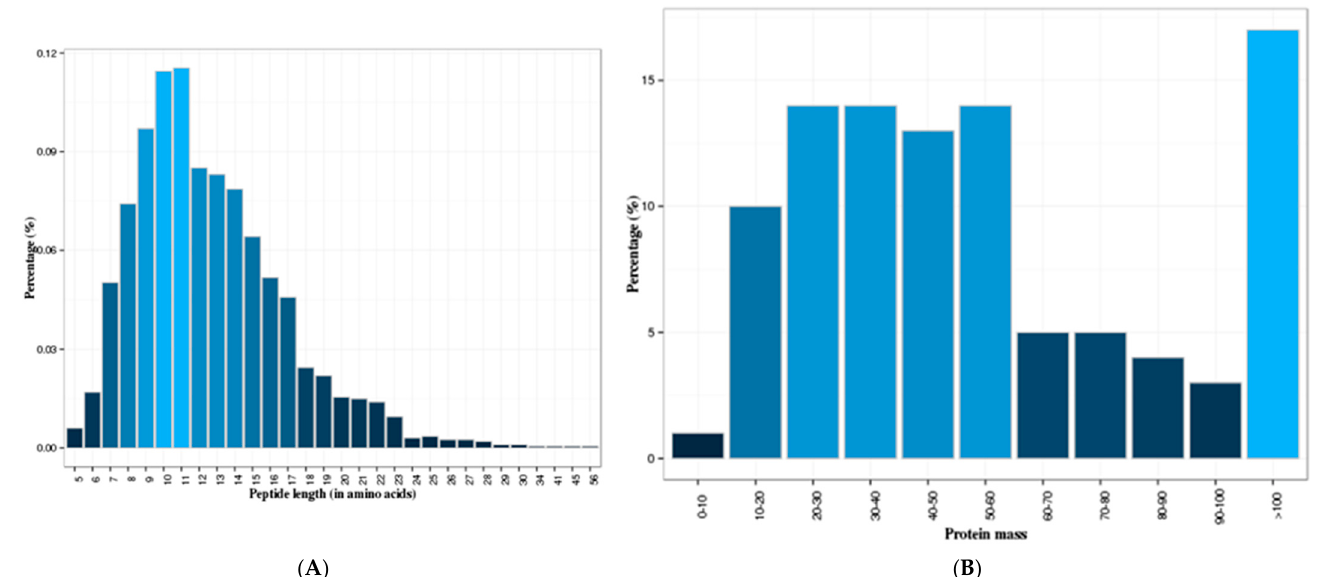
Figure 1. Information on yak skim milk protein identification. ( A ) The proportion of different length peptides. ( B ) The mass distribution of all identified proteins. The x -axis indicates the molecular weight (kDa).